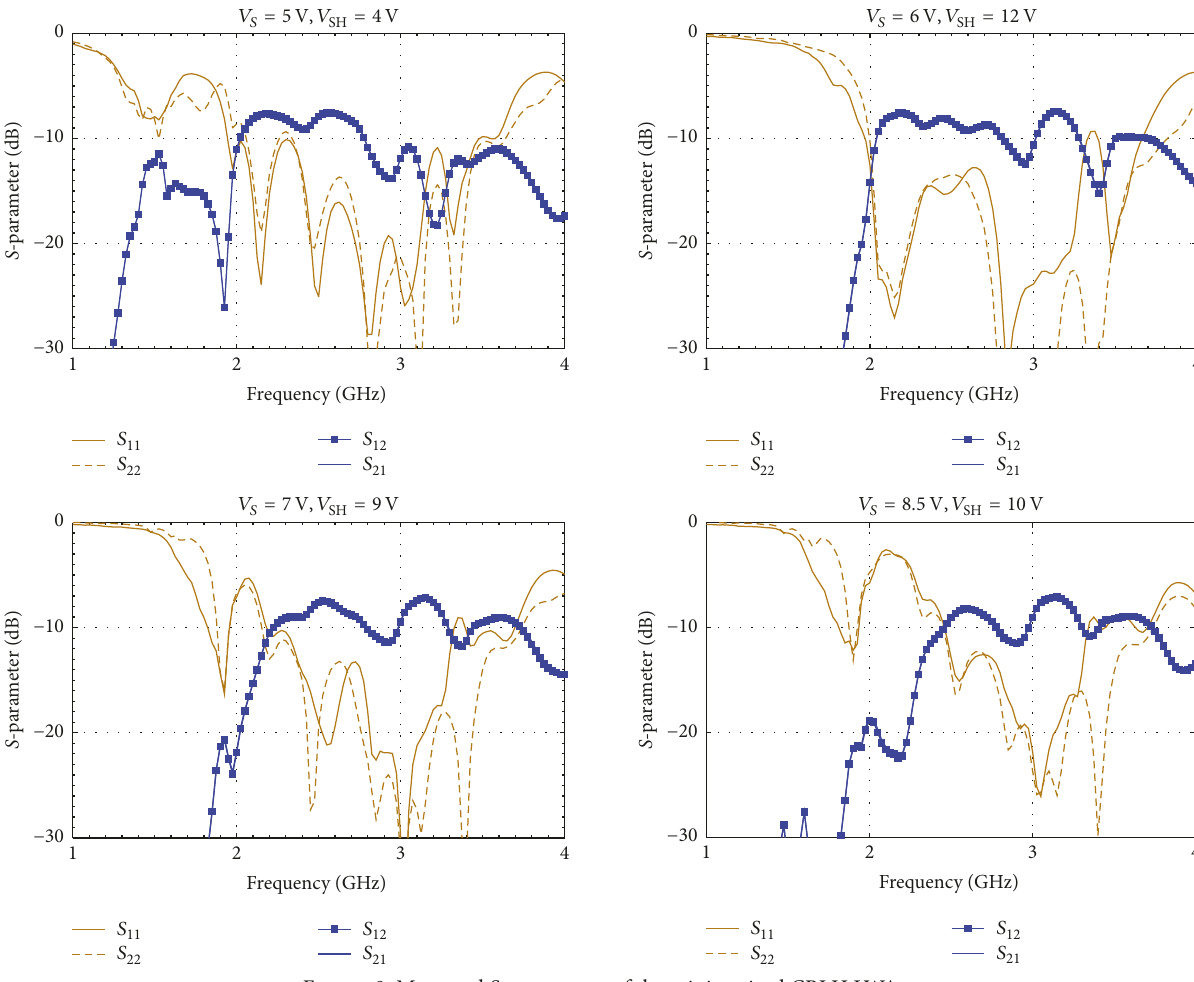
Figure 9: Measured 𝑆 -parameters of the miniaturized CRLH